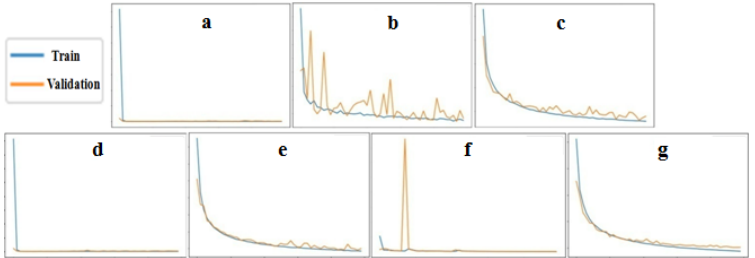
Figure 8. The training loss curves of the seven DNNs for the training and validation